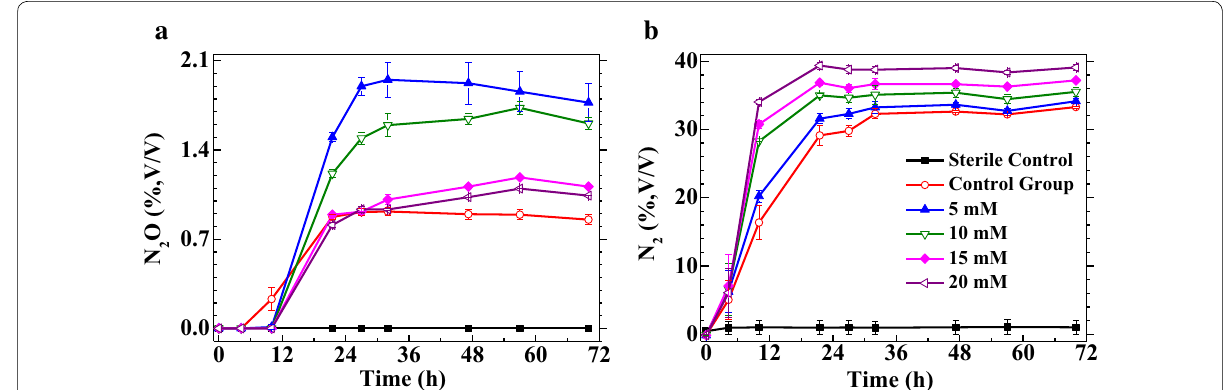
Fig. 4 Effects of CoHis absorbent on gas products of nitrate reduction under aerobic atmosphere by strain LYM: a N 2 O, b N 2